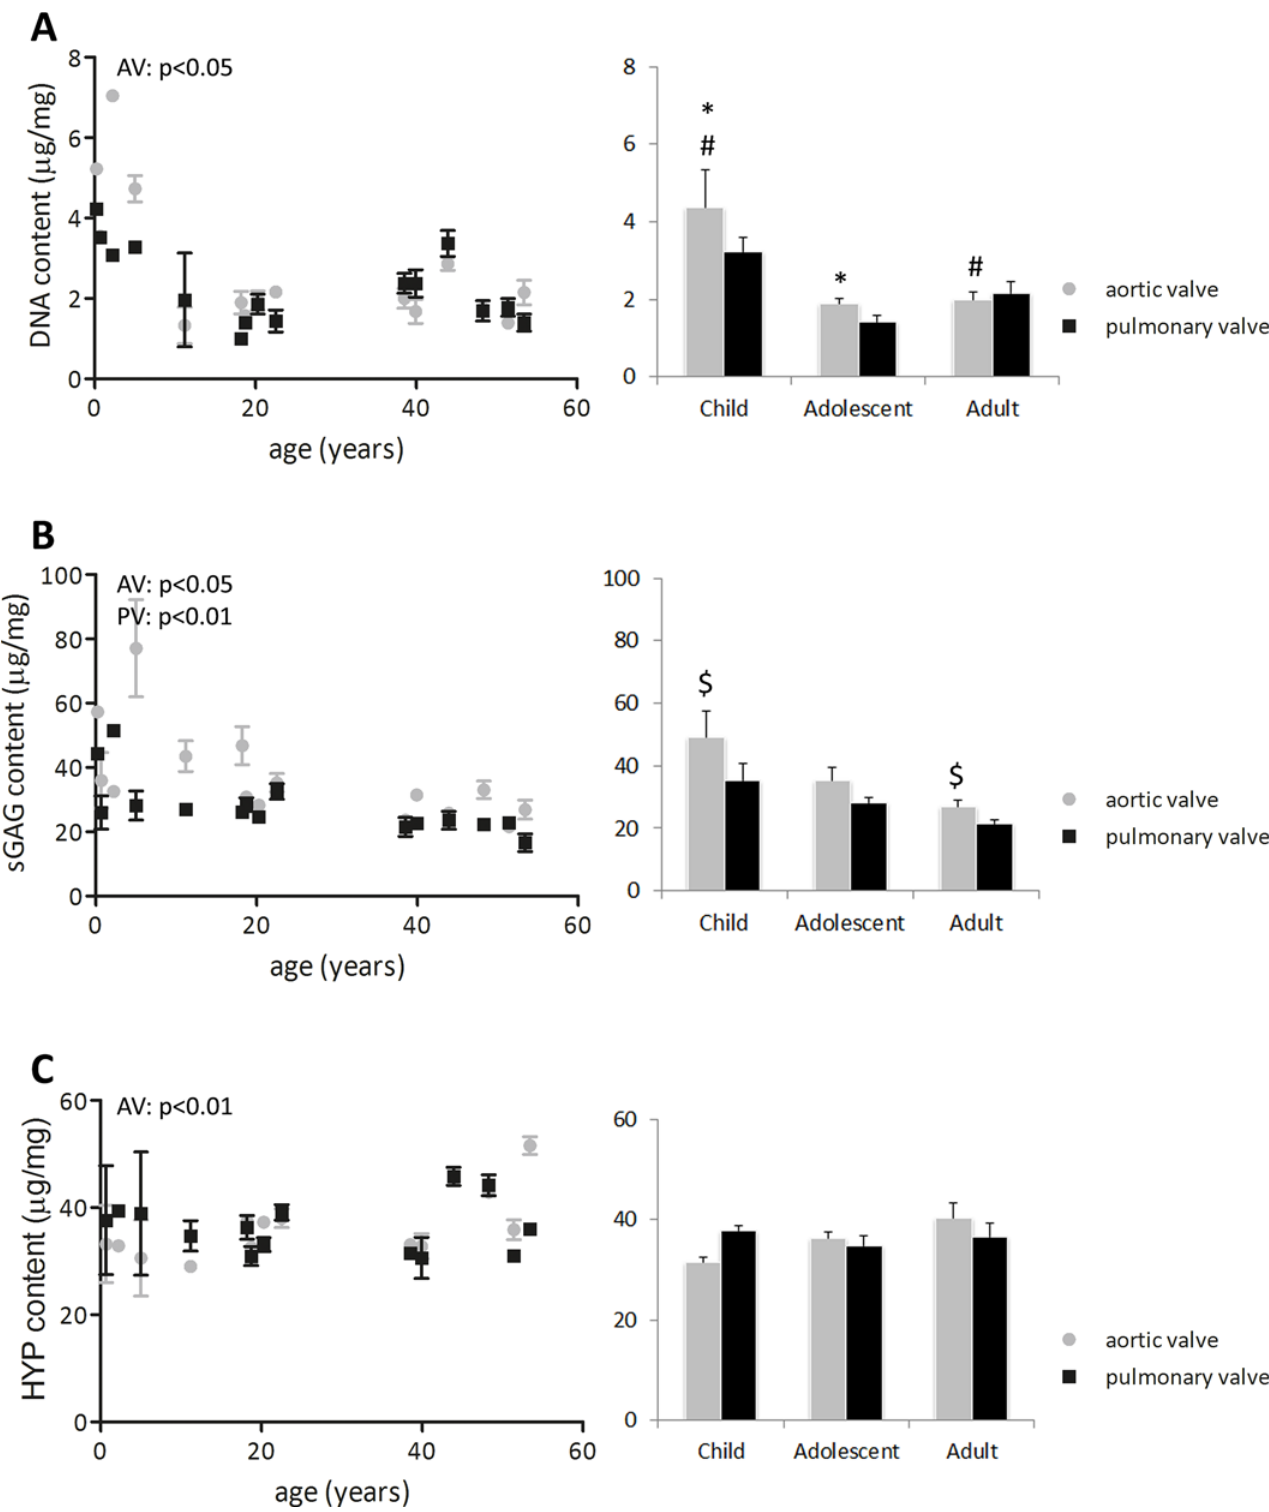
Fig 4. Changes in DNA-, sGAG-, and hydroxyproline (HYP) content. Changes in DNA- (A), sGAG- (B), and hydroxyproline (HYP) content (C) in μ g/mg dry weight (left side: all data points used for correlation analysis with age; right side: grouped data). DNA content is higher in children, especially in the first years of life (0 – 4 years), compared to the adolescents and adults. sGAG content decreases with age. Hydroxyproline content increases with age in the aortic valve. Differences between groups (p < 0.05) are indicated by paired symbols. AV: aortic valve, PV: pulmonary valve. doi:10.1371/journal.pone.0149020.g004 PLOS ONE | DOI:10.1371/journal.pone.0149020 February 11,